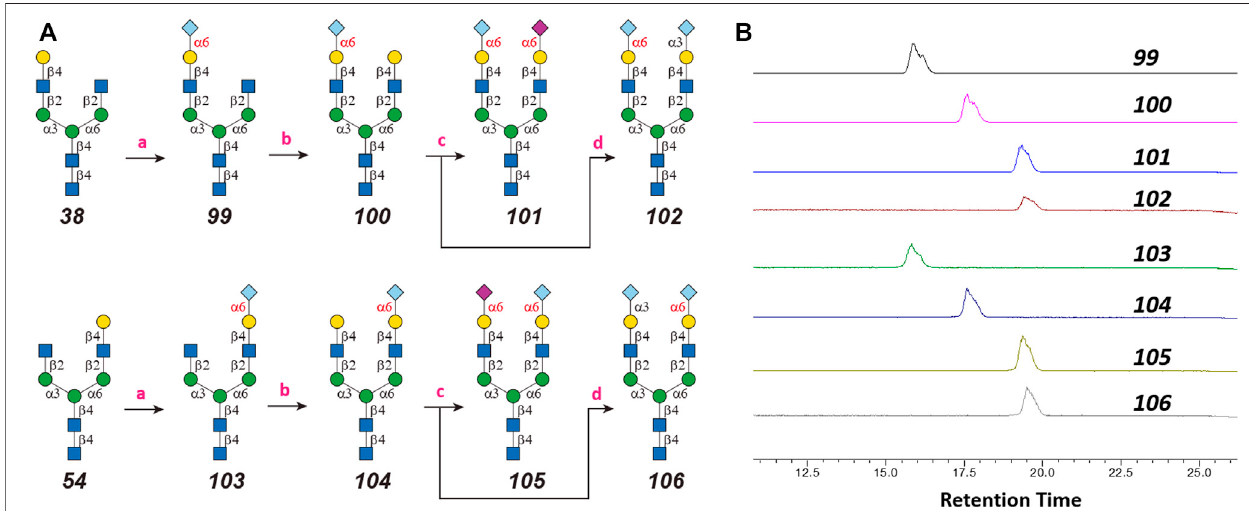
FIGURE 2 | Enzymatic synthesis of Neu5Gc-containing asymmetric N -glycans: (A) a, α 2-6sialylation with Pd26ST, NmCSS, CTP, and Neu5Gc; b, β 1- 4galactosylation with NmLgtB and UDP-Gal; c, α 2-6sialylation with Pd26ST, NmCSS, CTP, and Neu5Ac; d, α 2-3sialylation with PmST1-M144D, NmCSS, CTP, and Neu5Gc; (B) HPLC analysis of puri fi ed N